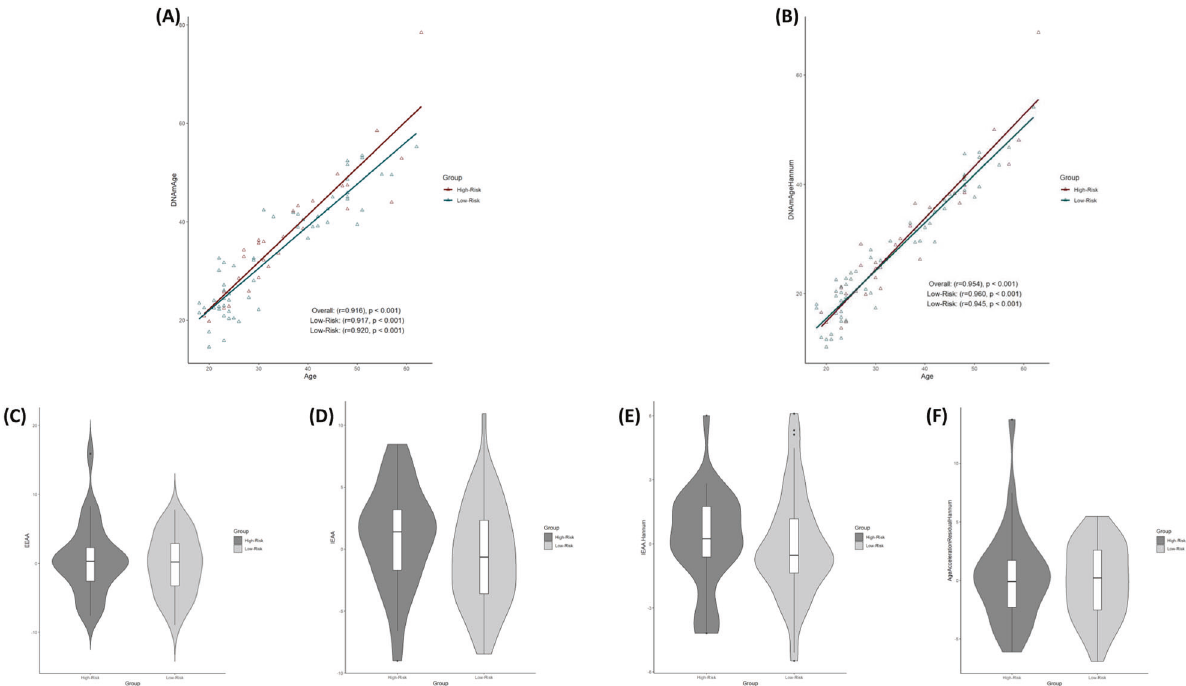
Fig. 1 Horvath and Hannum epigenetic age acceleration. A , B Scatterplots show Horvath or Hannum Age vs chronological age. Pearson ’ s correlation analysis indicated a signi fi cant correlation between DNA methylation age and chronological age in both groups. C – F Violin plot with boxplots show Horvath EAA, IEAA, Hannum EAA, or EEAA. Between-group comparisons were conducted using a Student ’ s t -test. No signi fi cant between group differences were revealed ( p > 0.1). EAA epigenetic age acceleration, IEAA intrinsic epigenetic age acceleration, EEAA extrinsic epigenetic age